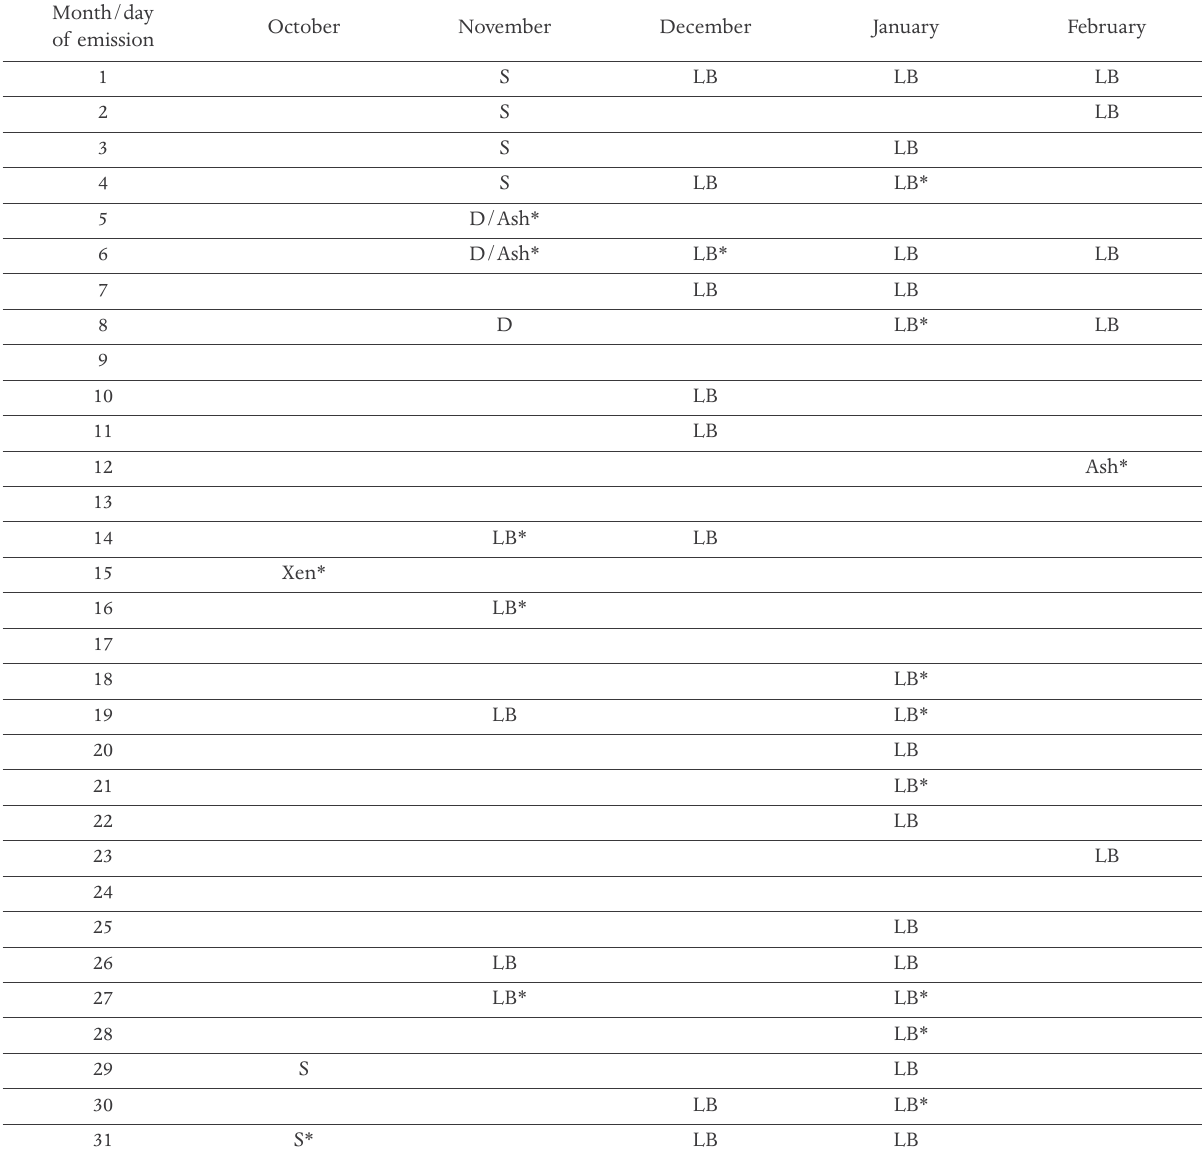
Table 2. Calendar with the days of emission and sampling of volcanic ash (in the water column), floating scoria and lava balloons. The days of intense degassing are included as well. Xen = xenopumice; Ash = volcanic ash in water column; S = scoriaceous blocks; D = days with intense degassing; LB = lava balloons. Asterisks indicate days when sampling of products